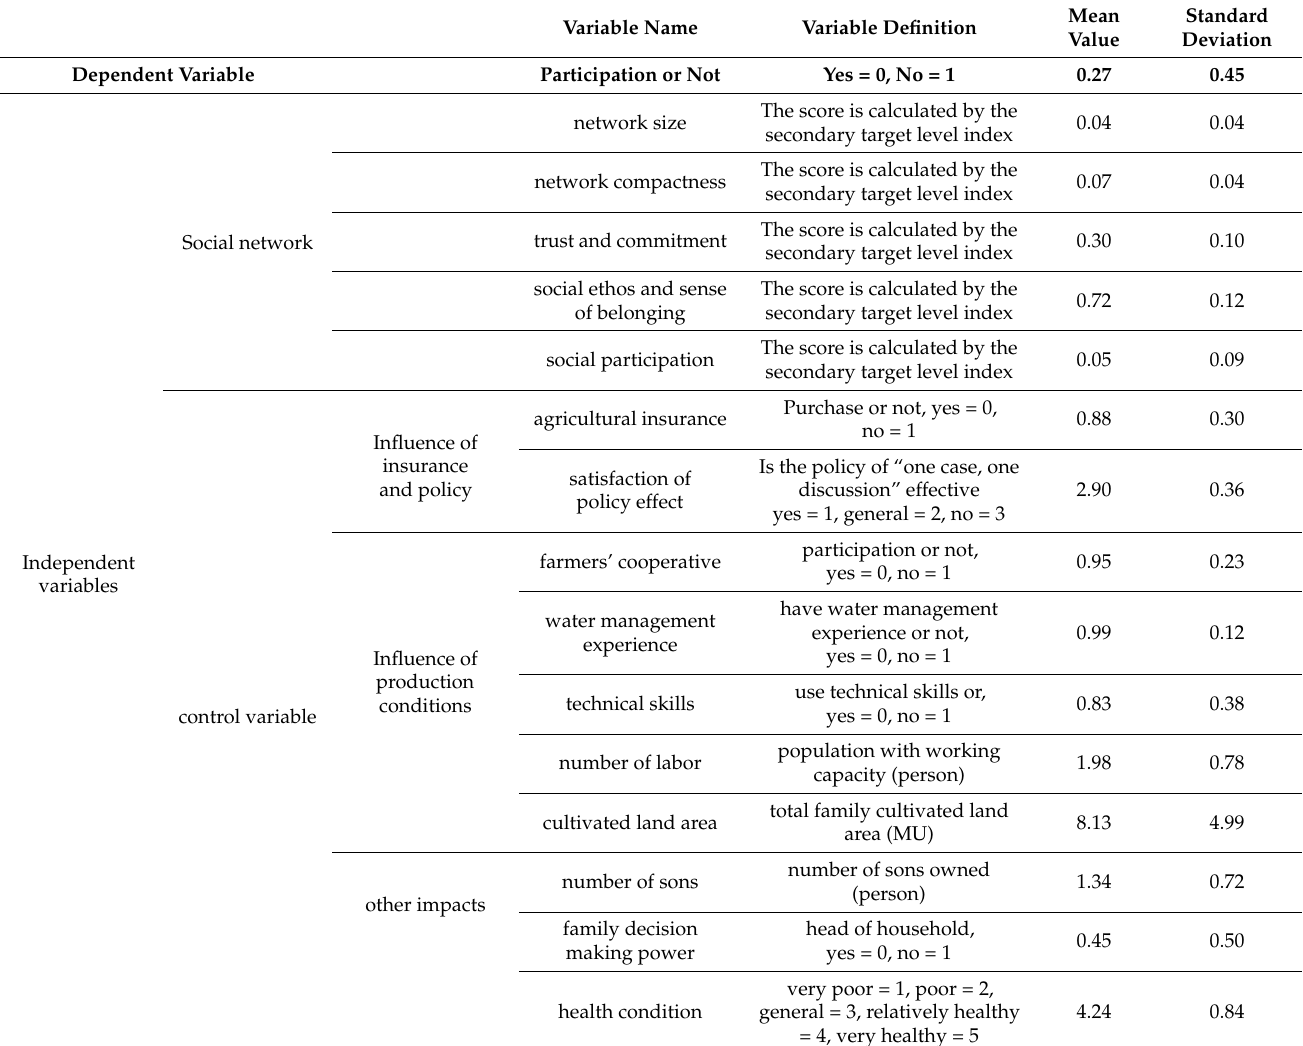
Table 2. The related variables of driving factors of social network relationship.